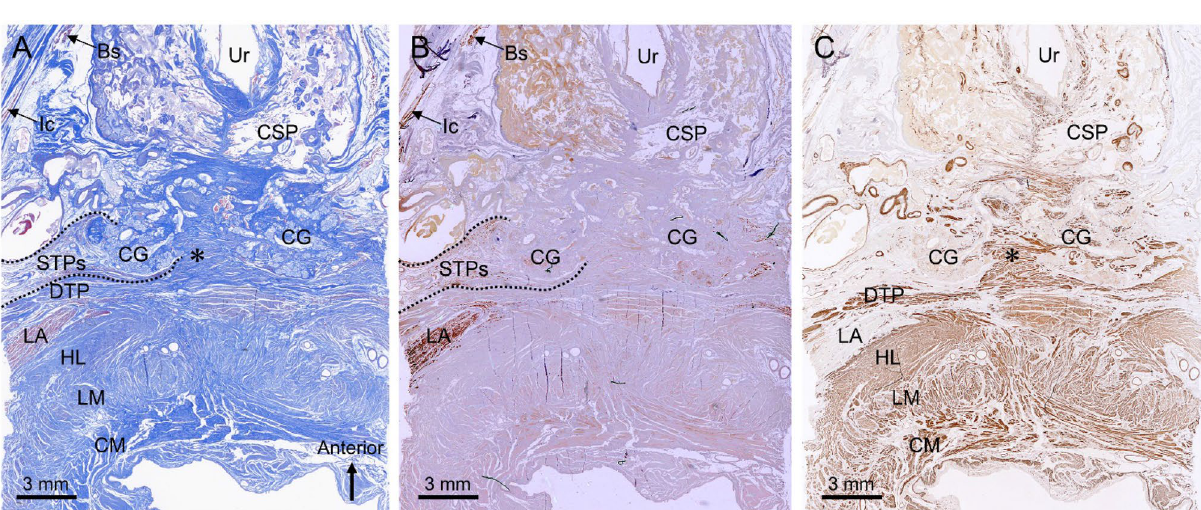
Figure 4. Transverse sections of the Cowper’s gland and surrounding muscles. ( A ) The Sect. 4 mm from the superior side of Fig. 3C, stained with Masson’s trichrome, in which the CG was observed posterior to the CSP. The STPs and DTP were located lateral and posterior to the CG. ( B ) Immunostaining for striated muscle. The striated muscle fibers of the STPs covered the lateral side of the CG. ( C ) Immunostaining for smooth muscle. The DTP consisted of smooth muscle and formed plate-like wall posterior to the CG. Its smooth muscle fibers extended between the bilateral CGs and between their lobules (asterisk). Bs bulbospongiosus, CG Cowper’s gland, CM circular muscle, CSP corpus spongiosum penis, DTP deep transverse perineal muscle, HL hiatal ligament, Ic ischiocavernosus, LA levator ani, LM longitudinal muscle, STP superficial transverse perineal muscle, STPs superior bundle of the STP, Ur